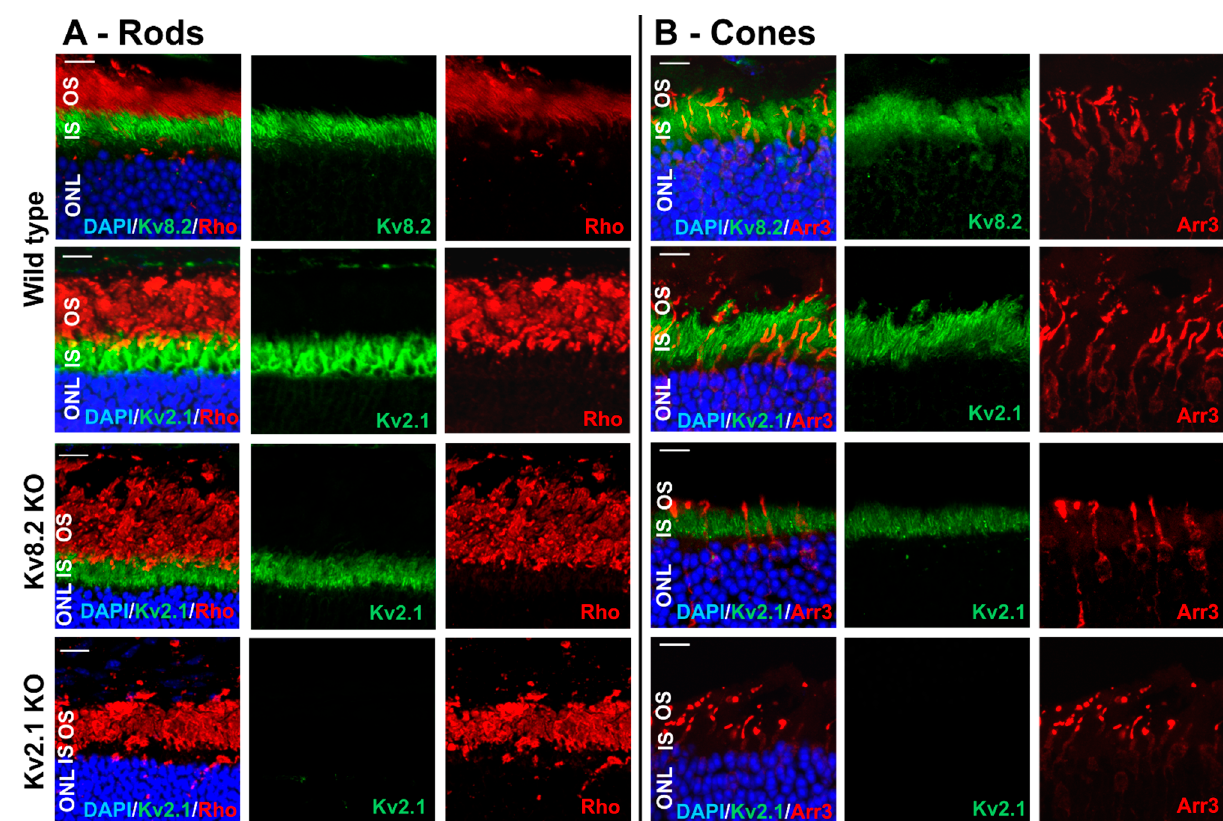
Figure 2. Representative confocal images of wild type and knockout (KO) retinas from central (10° from optic nerve) dorsal-ventral areas showing signal overlap of ( A ) rhodopsin (Rho, red) or ( B ) cone arrestin (Arr3, red) with both Kv subunits in wild type and Kv2.1 subunit in Kv8.2 KO retinas (green). No anti-Kv8.2 and anti-Kv2.1 staining was observed in the Kv2.1 KO retinas. ONL, outer nuclear layer; IS, inner segment; INL, inner nuclear layer; OS, outer segment. Scale bar = 20 μ M.